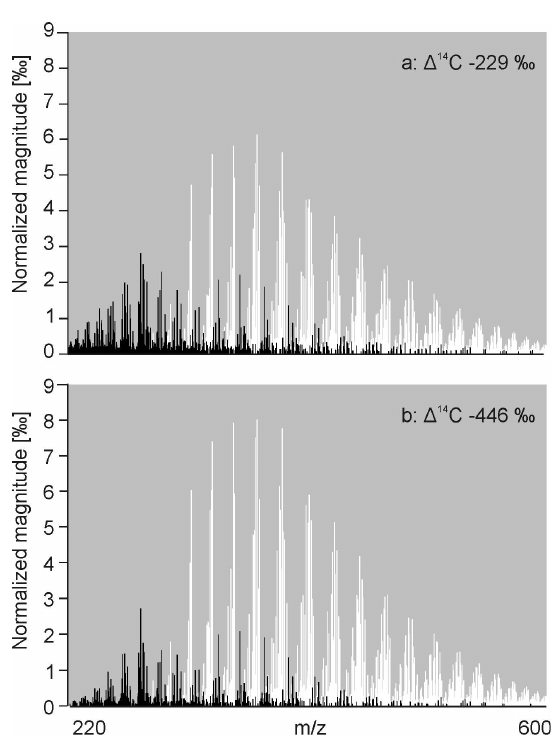
Fig. 6. Selected normalized FT-ICR mass peaks of eastern Atlantic Ocean SPE-DOM. The mass peaks show a significant linear correlation with 1 14 C. (a) Surface sample extract with 1 14 C= − 229‰ and (b) deep sea sample extract with 1 14 C= − 446‰. The black colored masses are positively correlated with 1 14 C and are present in a higher proportion in the more recent SPE-DOM, whereas the white colored masses are negatively correlated with 1 14 C and present in a higher proportion in the aged SPE-DOM. The difference in the m/z between black and white masses is also reflected in the weighted average m/z of the whole SPE-DOM spectra and shifts from 407 (surface sample, 1 14 C= − 229) to 413 (deep sea sample, 1 14 C= −